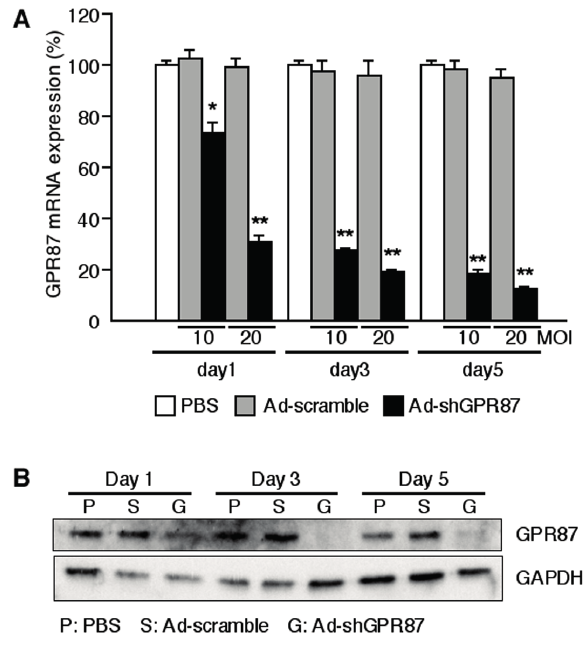
Figure 2. Expression of GPR87 in GPR87-expressing human bladder cancer cells RT112 after infection with adenoviral vectors. ( A ) Time-dependent and dose-dependent GPR87 gene expressions in RT112 cell; ( B ) Time-dependent GPR87 protein expressions in RT112 cells. MOI: multiplicity of infection; * p < 0.05; ** p < 0.005, vs. Ad-scramble treatment.